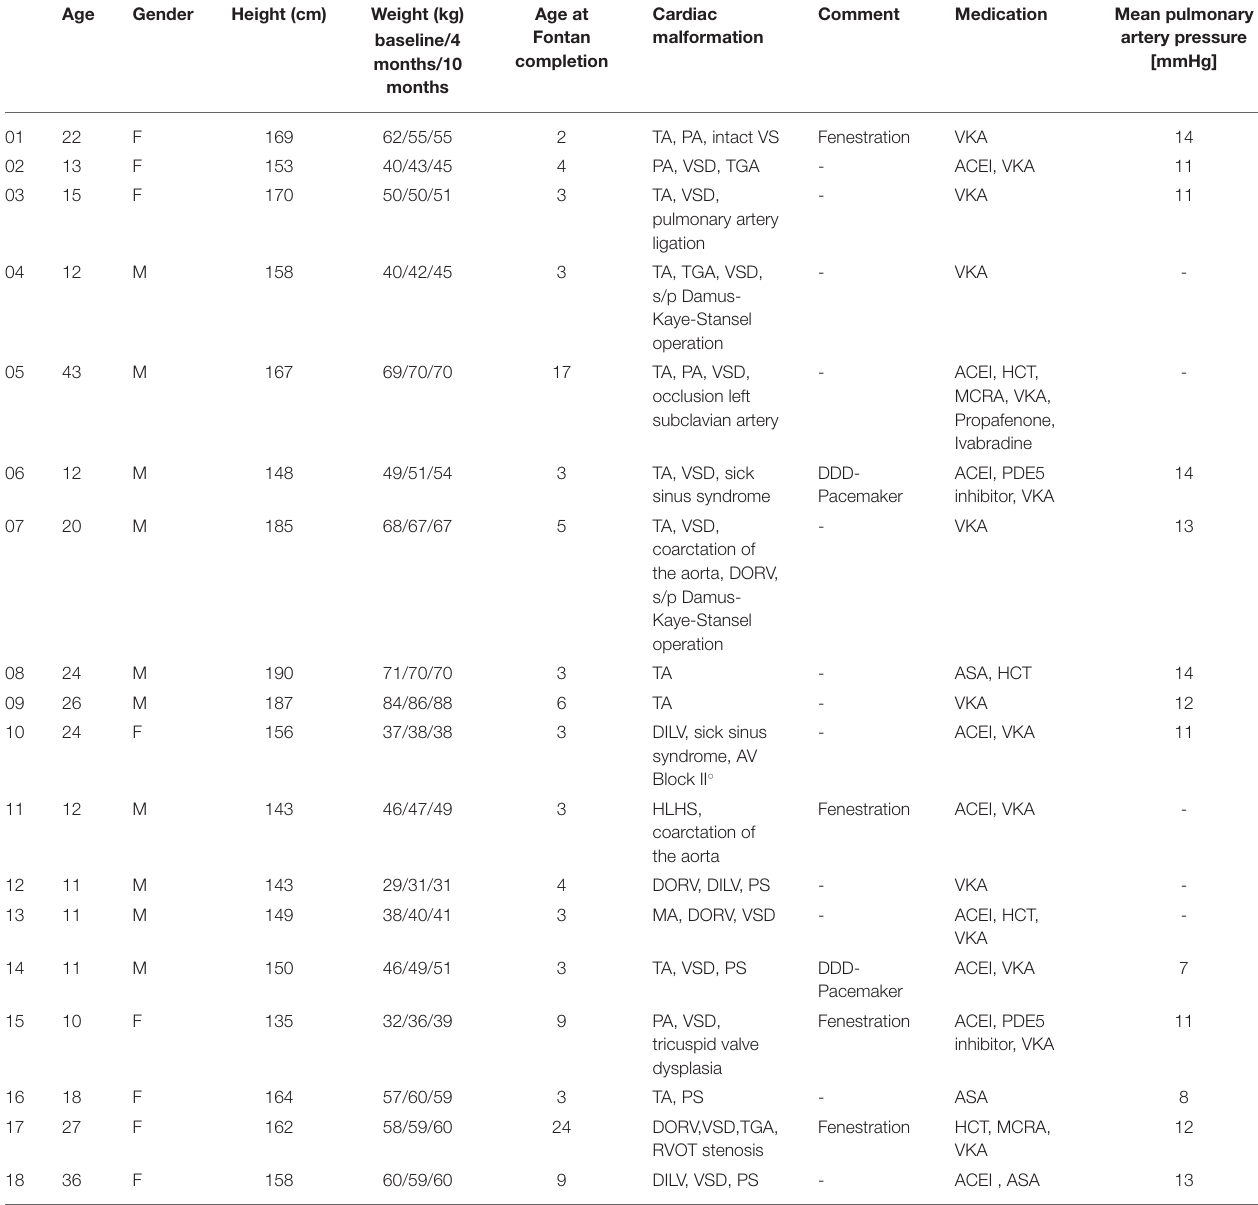
TABLE 2 | Baseline patients’